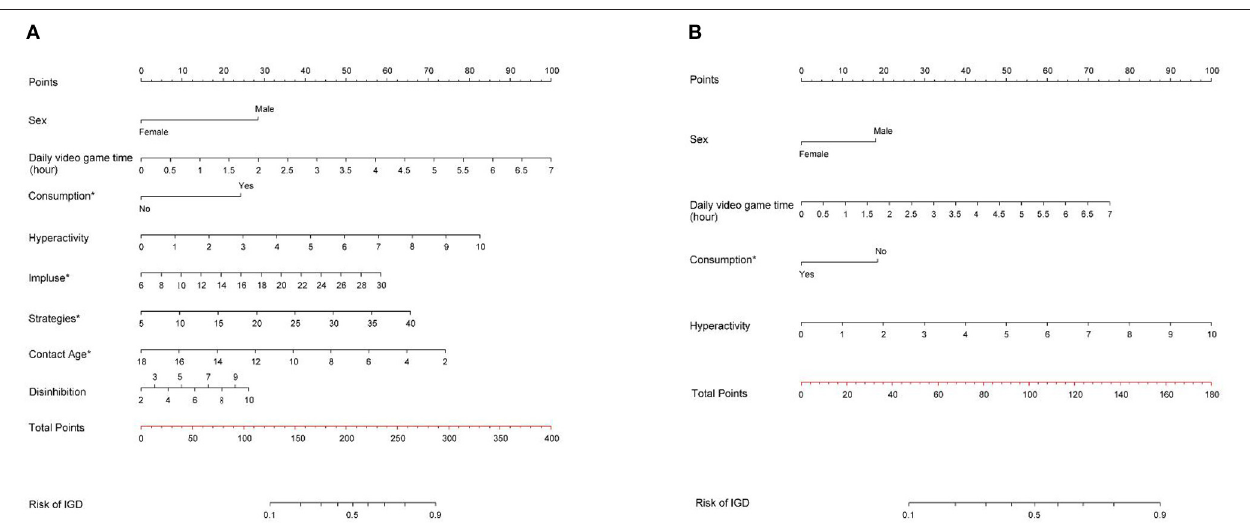
FIGURE 2 | Nomograms for predicting the risk of Internet gaming disorder in children and adolescents. (A) Model 1; (B) Model 2. Consumption*: Experience of video game consumption; Impulse*: Impulse control difficulties; Strategies*: limited access to emotion regulation strategies; Contact age*: Age at the start of contact with video